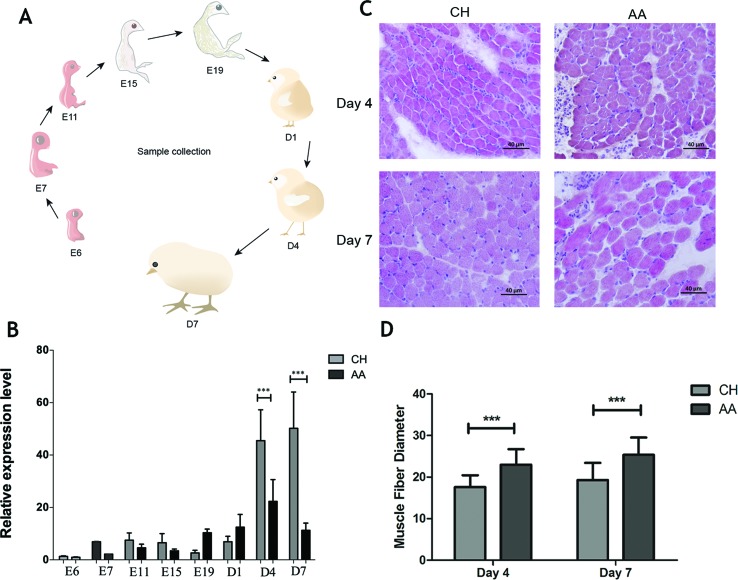
Expression analysis of Atrogin-1 in AA and CH during different developmental stages. (A) The developmental stages analyzed. (B) Relative expression level of Atrogin-1 detected by q-PCR. The mRNA expression was compared with the GAPDH gene. Mean ± SD was present for each group (n = 3). The bar means SD of the three sample expressions. *** means P < 0.001. Chahua (CH) and Arbor Acres (AA). (C) HE staining of skeletal muscle from 4- and 7-day-old CH and AA, upper left is CH at day four, upper right is AA at day four, below left is CH at day seven, below right is AA at day seven. (D) Myofiber size of 4- and 7-day- old CH and AA chickens. Three replicates were considered for each species, and 300 myofibers were calculated in each section. Mean ± SD was present for each group (n = 3). The bar means SD of the three sample expressions. *** means P < 0.001. Chahua (CH) and Arbor Acres (AA).